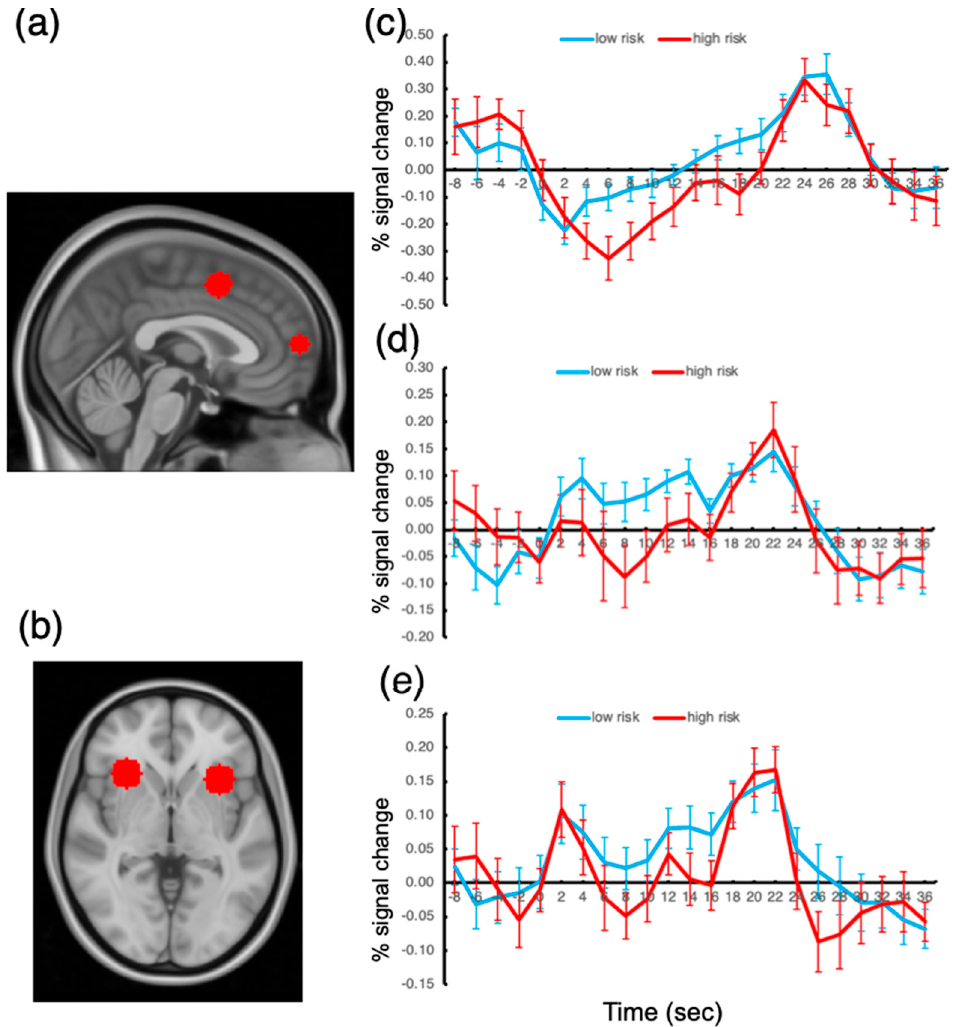
Figure 4. Anatomical locations of the ROIs and activation time courses. ( a ) FPC and ACC ROIs. ( b ) AI ROI. ( c ) Activation time course for FPC. ( d ) Activation time course for ACC. ( e ) Activation time course for AI. Error bars represent the standard errors of the mean.